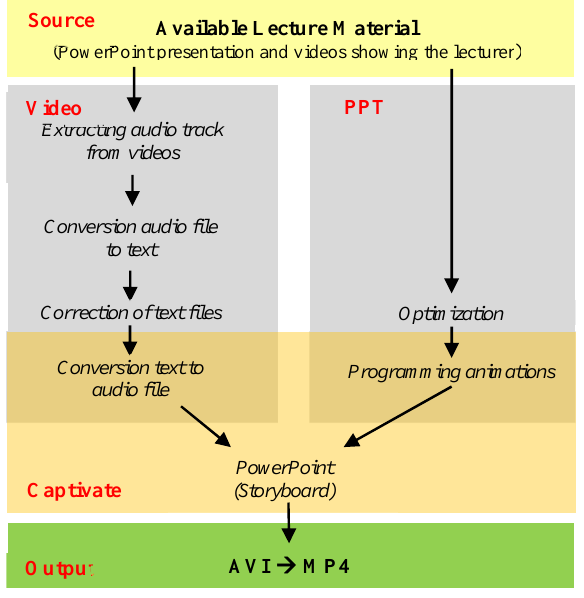
Figure 1: Flowchart for podcast production